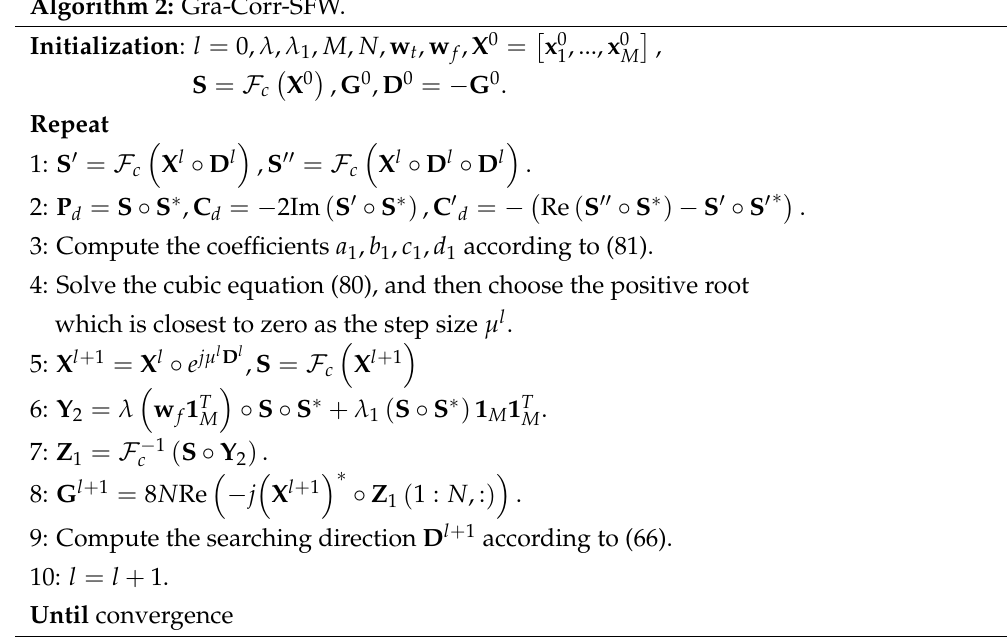
Algorithm 2: Gra-Corr-SFW.